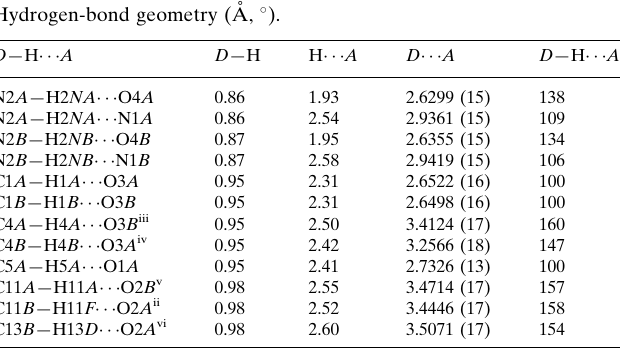
Hydrogen-bond geometry (A˚ , (cid:4)